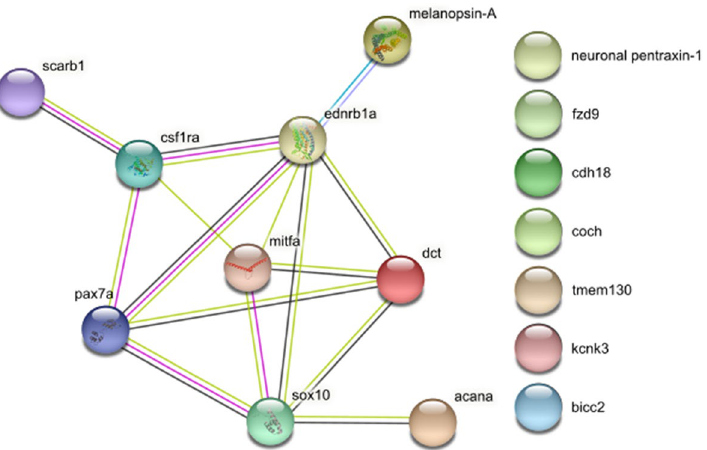
Figure 6. A protein–protein interaction map of zebrafish gene orthologues. The analysis was performed using STRING 10 , claudin-24 was not included. The interactions were determined and colour-coded by homology (violet), co-expression (black), experiments (pink), databases (turquoise), and text mining (light green).